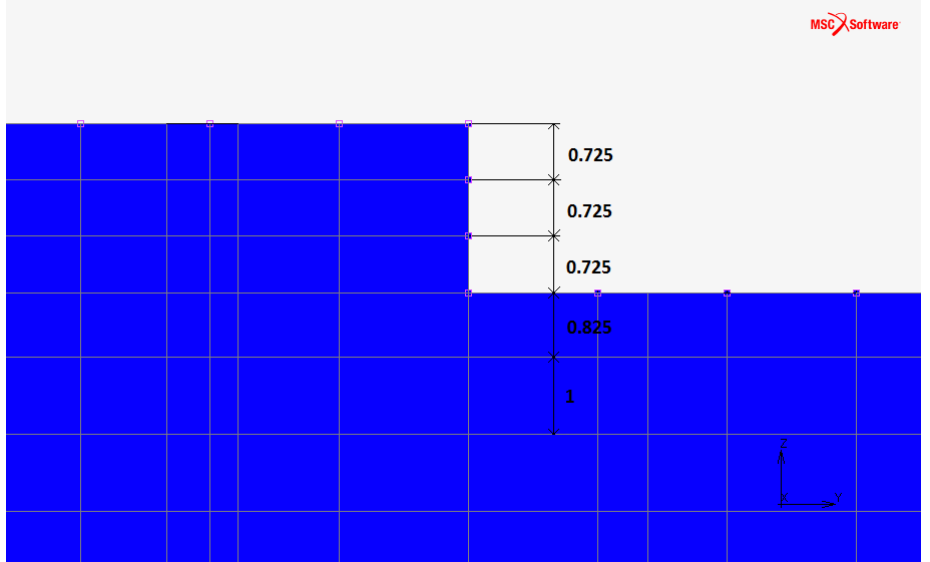
Figure 5. Monopolar plate—discretization along the z -axis in all the configurations (the dimension of each element is reported in mm). Table 2. Active area AA MEA [mm 2 ] and characteristic dimensions [mm] of the three plate configura- tions: l p is the length (square side or diameter) of plate plan view, l MEA is the length (square side or diameter) of the active area, t is the thickness of the plate, and l g is the depth of the groove. Conf. a Conf. b